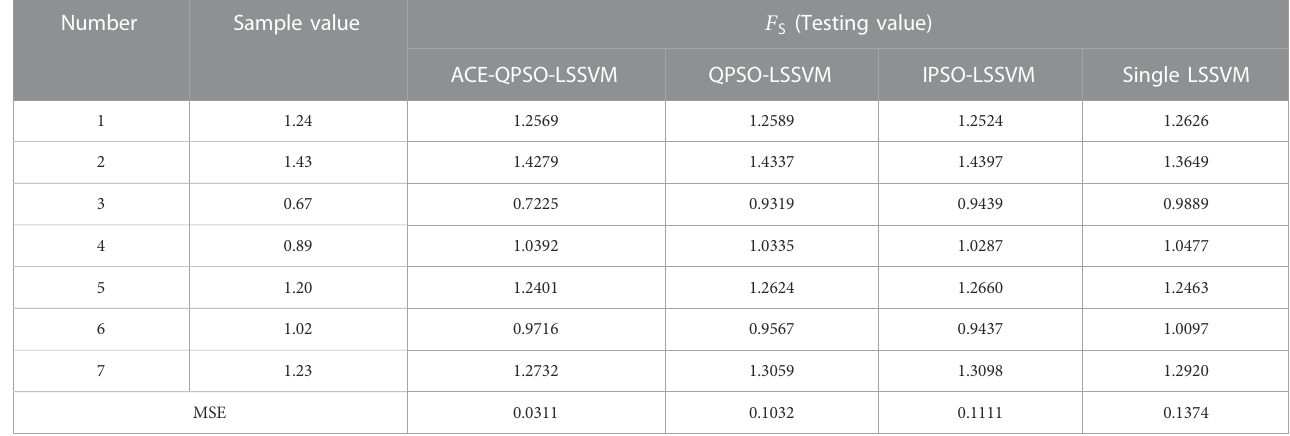
TABLE 5 Comparison between target and estimated values from each algorithm for the testing